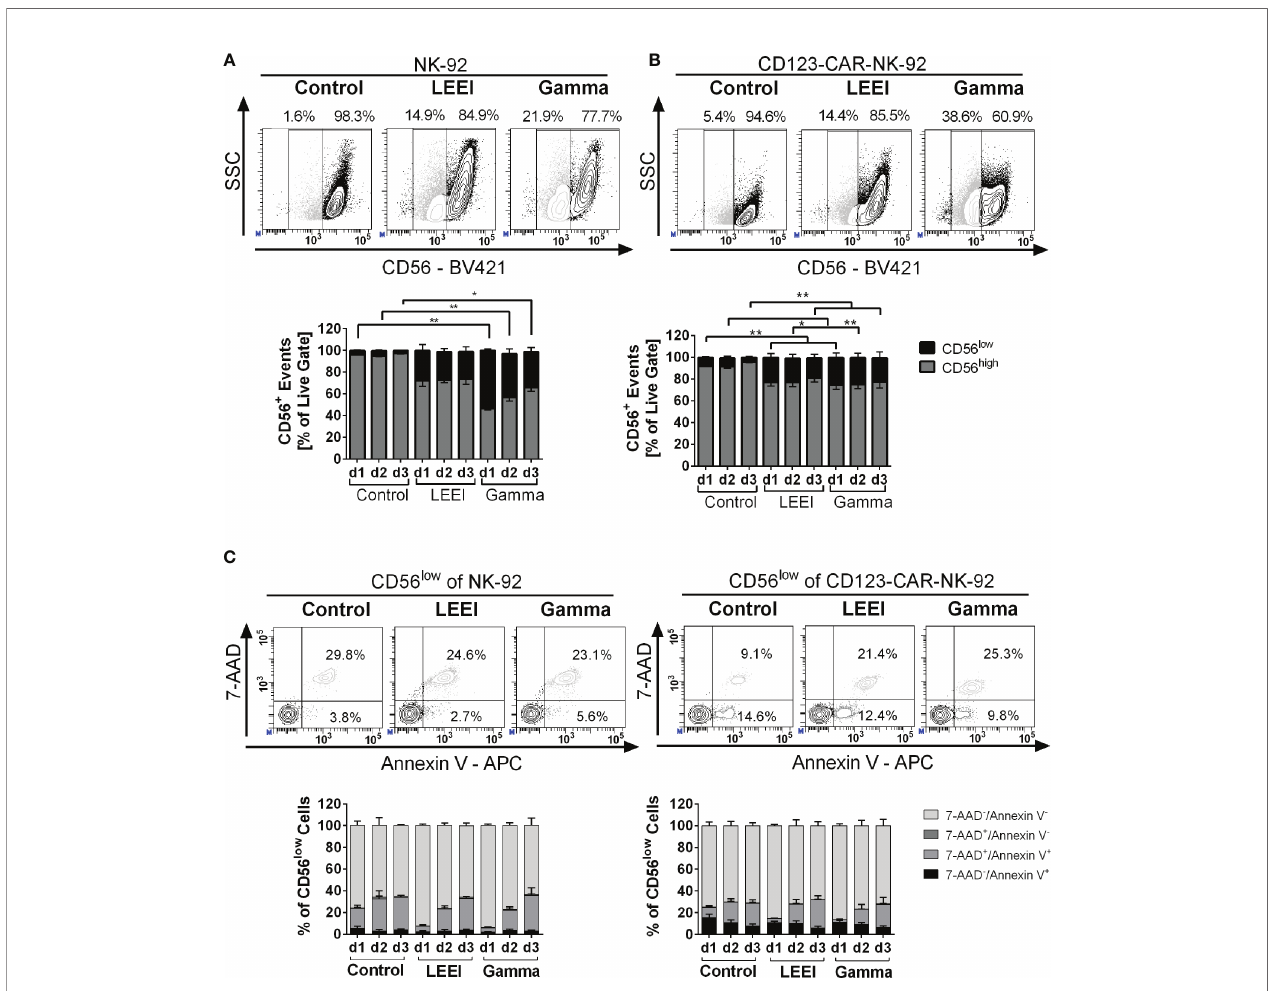
FIGURE 3 | Irradiation decreases surface expression of CD56. (A+B): NK-92 ( A , n = 4) and CD123-CAR-NK-92 cells ( B , n = 7) were stained with anti-human CD56 antibody. Surface expression levels of CD56 are indicated as CD56 low (black) and CD56 high (grey). Representative contour plots of non-irradiated (control), LEE-irradiated, and gamma-irradiated cells on day 3 post-irradiation are shown. (C) Analysis of the CD56 low subpopulation of NK-92 (left) and CD123-CAR-NK-92 cells (right) regarding apoptosis: 7-AAD - /Annexin V - (lightest grey), 7-AAD + /Annexin V - (dark grey), 7-AAD + /Annexin V + (light grey) and 7-AAD − /Annexin V + (black). Representative contour plots of non-irradiated (control), LEE-irradiated, and gamma-irradiated cells on day 3 post-irradiation are shown. Values are indicated as means ± SEM, statistical signi fi cance is symbolized by asterisks (* for p ≤ 0.05 and ** for p ≤ 0.01, Kruskal-Wallis test adjusted for multiple comparisons by Dunn ’ s